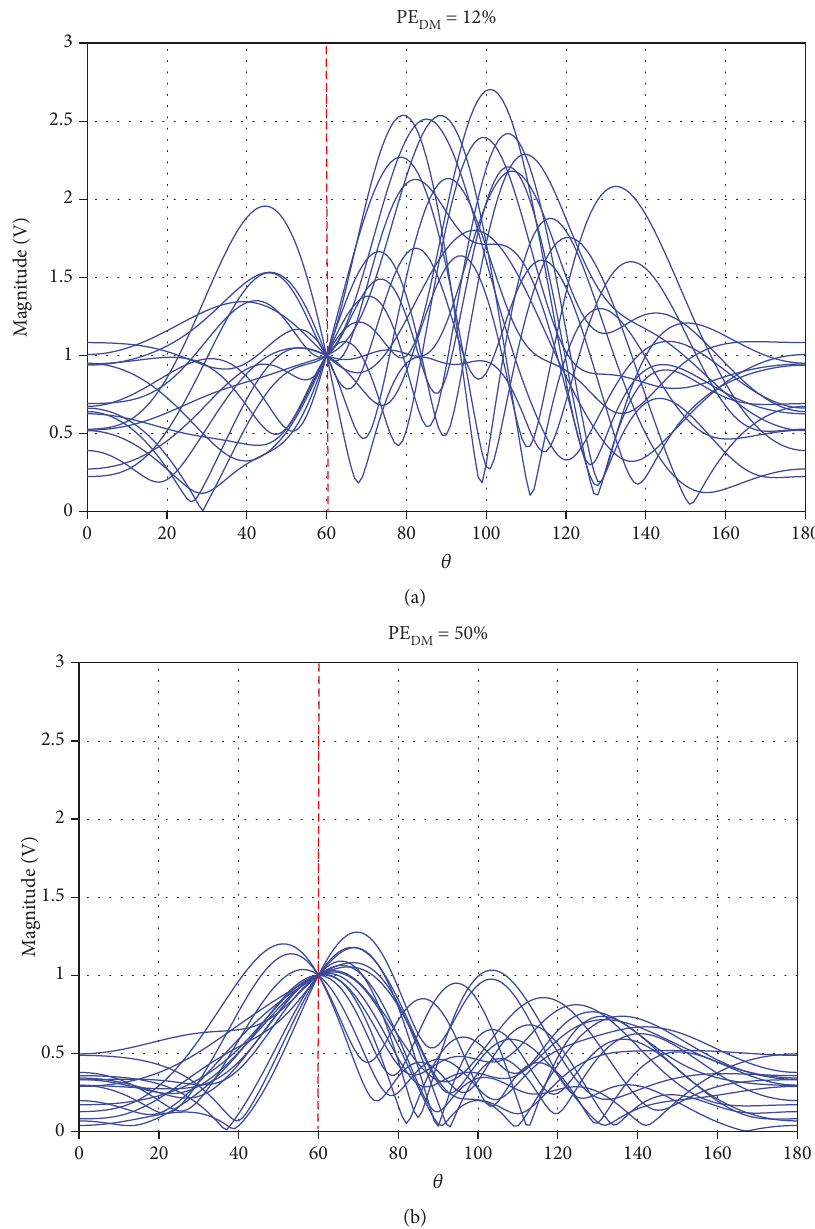
(ideal power divider and DM